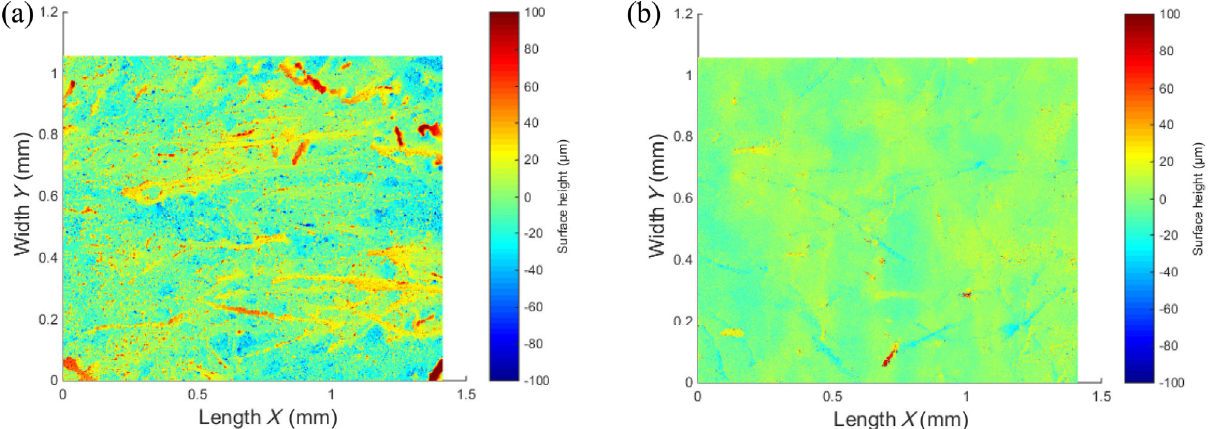
Fig. 12 Height of wear surfaces: (a) when Amontons’ law is valid (composite 15 SF at a contact pressure of 0.20 MPa), (b) when Amontons’ law is not valid (composite 20 SF+silica at a contact pressure of 0.80